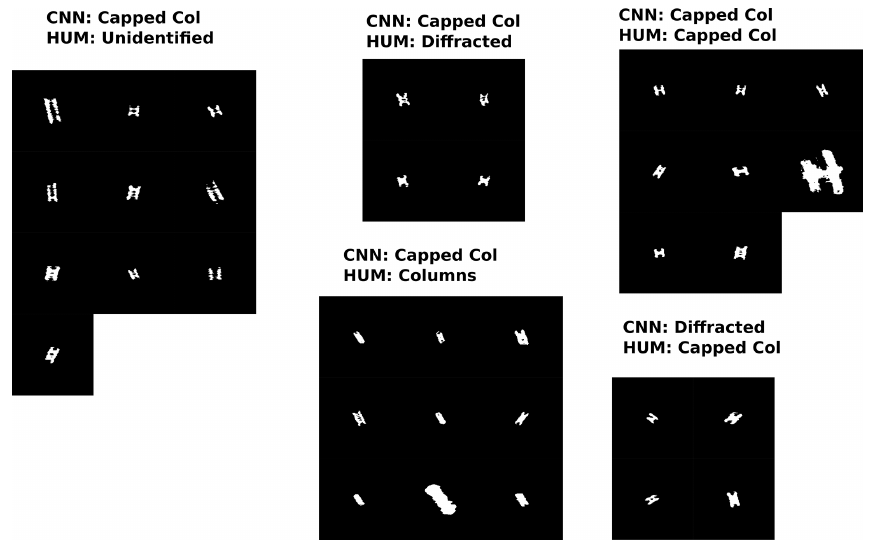
Figure A5. Images from the random inspections identified as capped columns by either the CNN or humans.